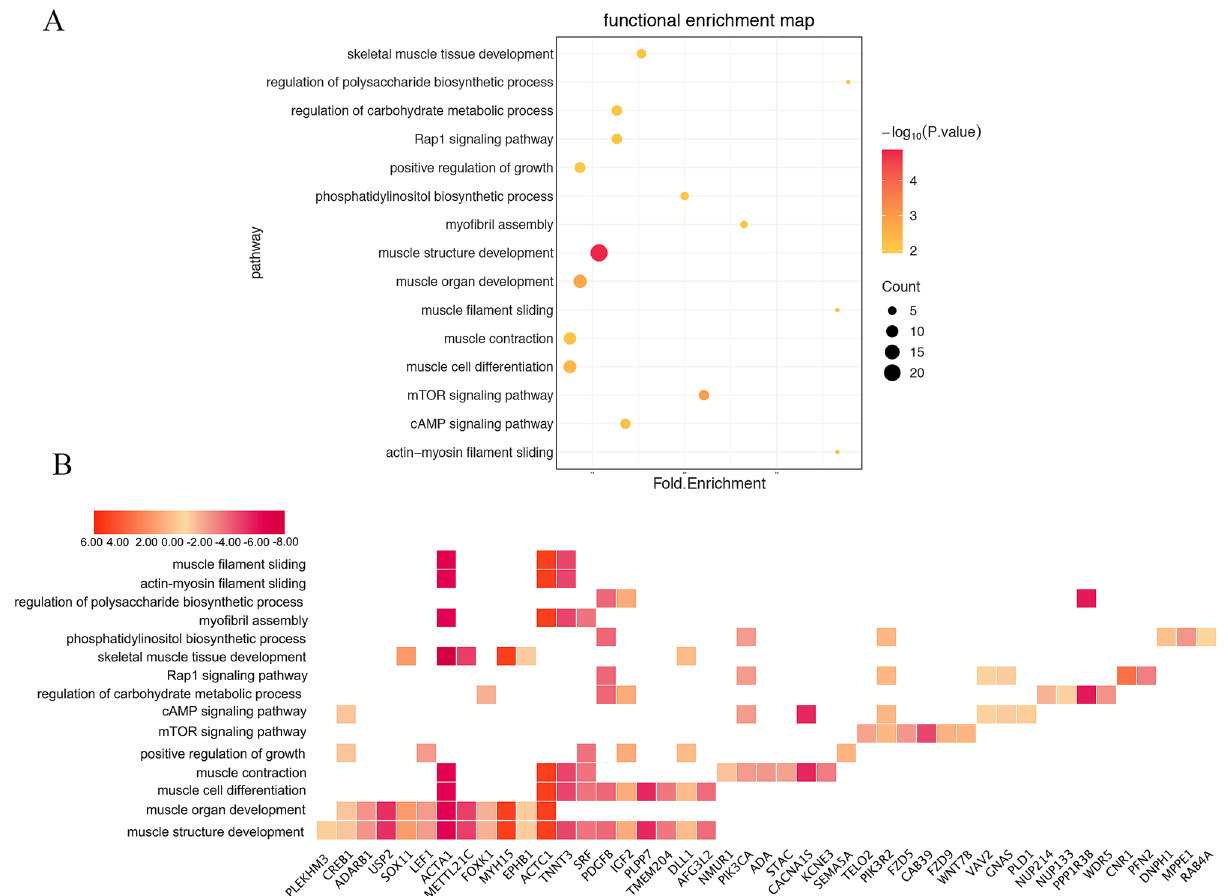
Figure 4. The results of Gene ontology and pathway analysis. ( A ) Gene ontology and pathway related to muscle development. ( B ) Gene expression in Gene ontology and pathway related to muscle development, the bar code represents the color scale of the log 10 (FC)